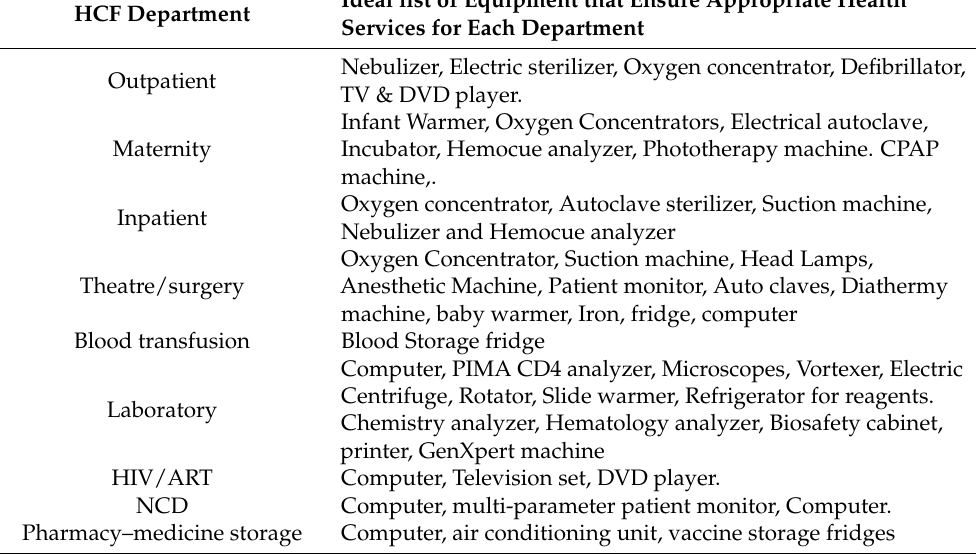
Table 1. Major electricity consuming equipment that ideally operate in a healthcare facility based on type of health